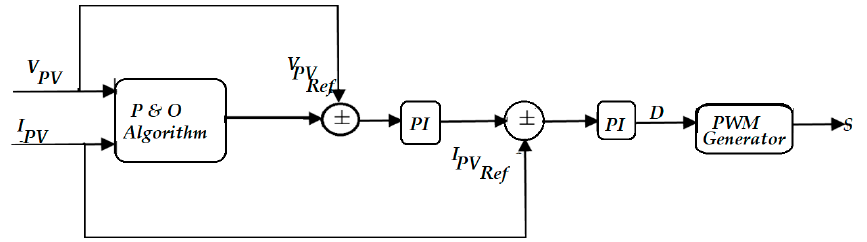
Figure 10. Pulse generator.